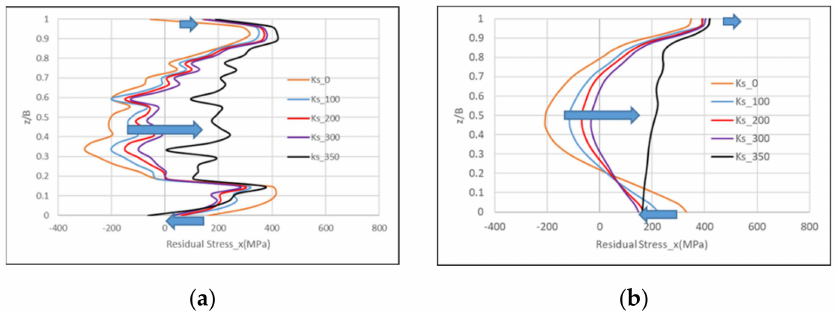
Figure 14. Welding residual stress in the width direction at the thickness of 70 mm and a yield stress of 330 MPa: ( a ) welding center and ( b ) welding toe.